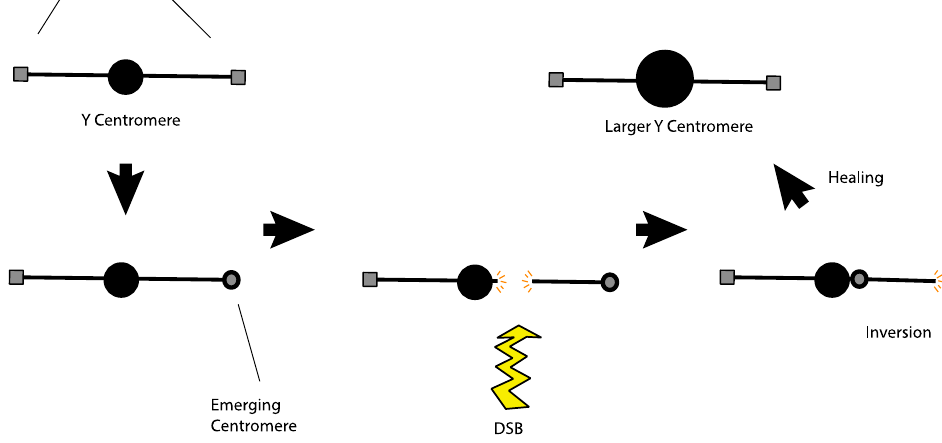
Figure 4. A model to explain how the Y centromere may have become enlarged as well as the occurrence of telomeric retrotransposons at the native Y centromere. A Y chromosome with an ancestral centromere (top left) begins to have centromeric properties emerge at the telomere. Since it is functionally a dicentric chromosome, this configuration will likely result in segregation problems. Those issues may be resolved if a single DSB near the centromere is followed by an inversion distal to the break, bringing the centromeres together. After healing, the result is a normal Y chromosome with a bigger centromere at the native locus which would also house telomeric retrotransposons from the ancestral telomeric region.